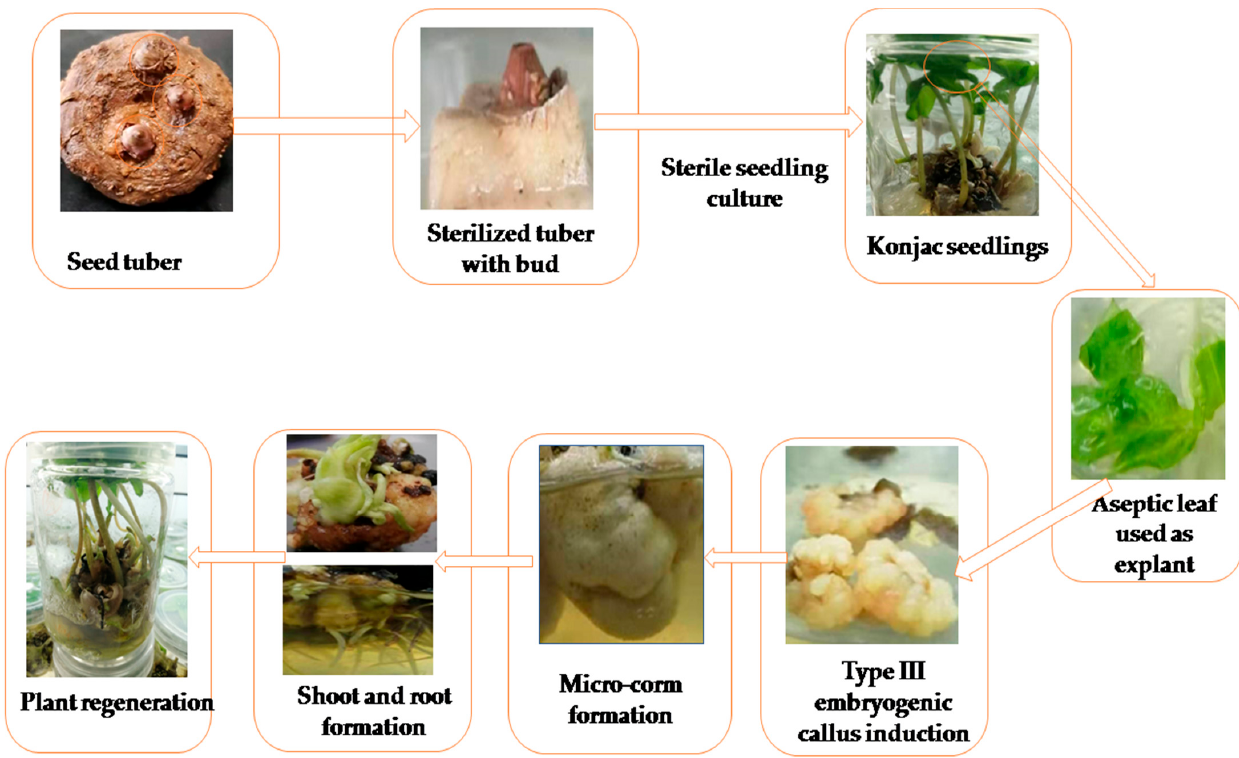
Figure 1. Proposed universal protocol for regeneration of the konjac plant from leaves as an explant. Starting from seed tuber sterilization in method C, seedling regeneration in MS medium, embryogenic callus induction in M1-5 medium, micro-corm regeneration in M2-9 medium, and seedling formation in M3-9 medium.